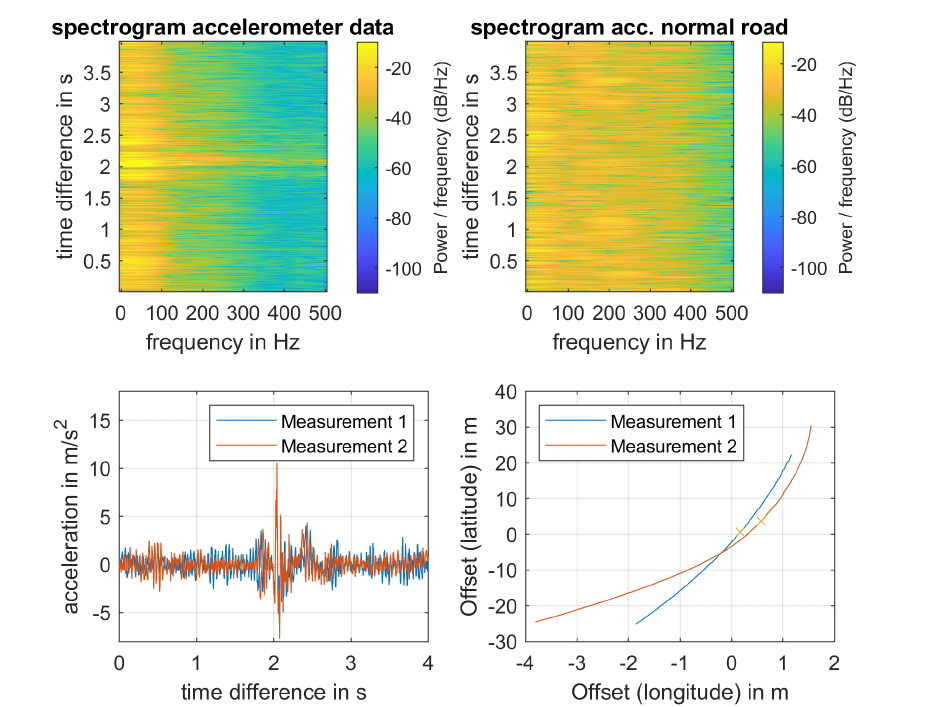
Figure 20. ( Top ): Spectrogram analysis of z -component of accelerometer data (Left: test-route, right: normal street). ( Bottom ): comparison of time-signals of z -accelerometer data and corresponding relative GPS position. The crosses in the GPS position plot indicate the relative time-stamp of 2s corresponding to the peaks being observed in the accelerometer